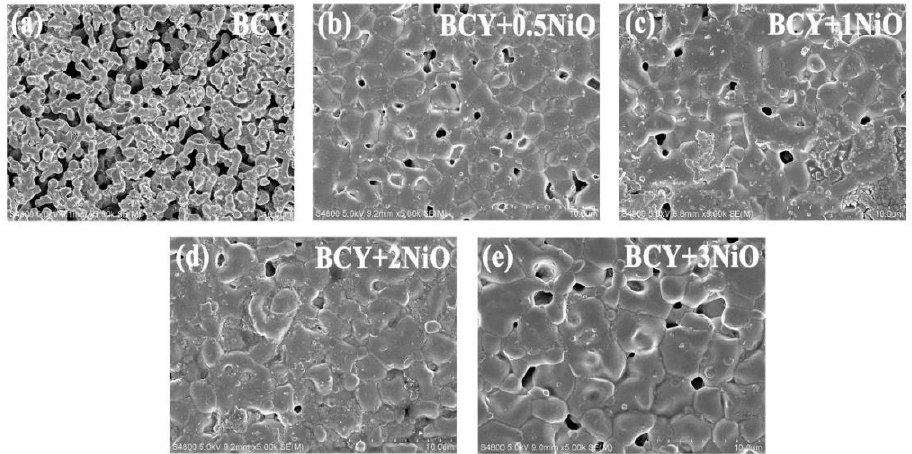
Figure 7. ( a )–( e ) SEM images of surfaces of NiO–BCY/BCY–NiO structures. Figure 7. ( a – e ) SEM images of surfaces of NiO–BCY/BCY–NiO structures.